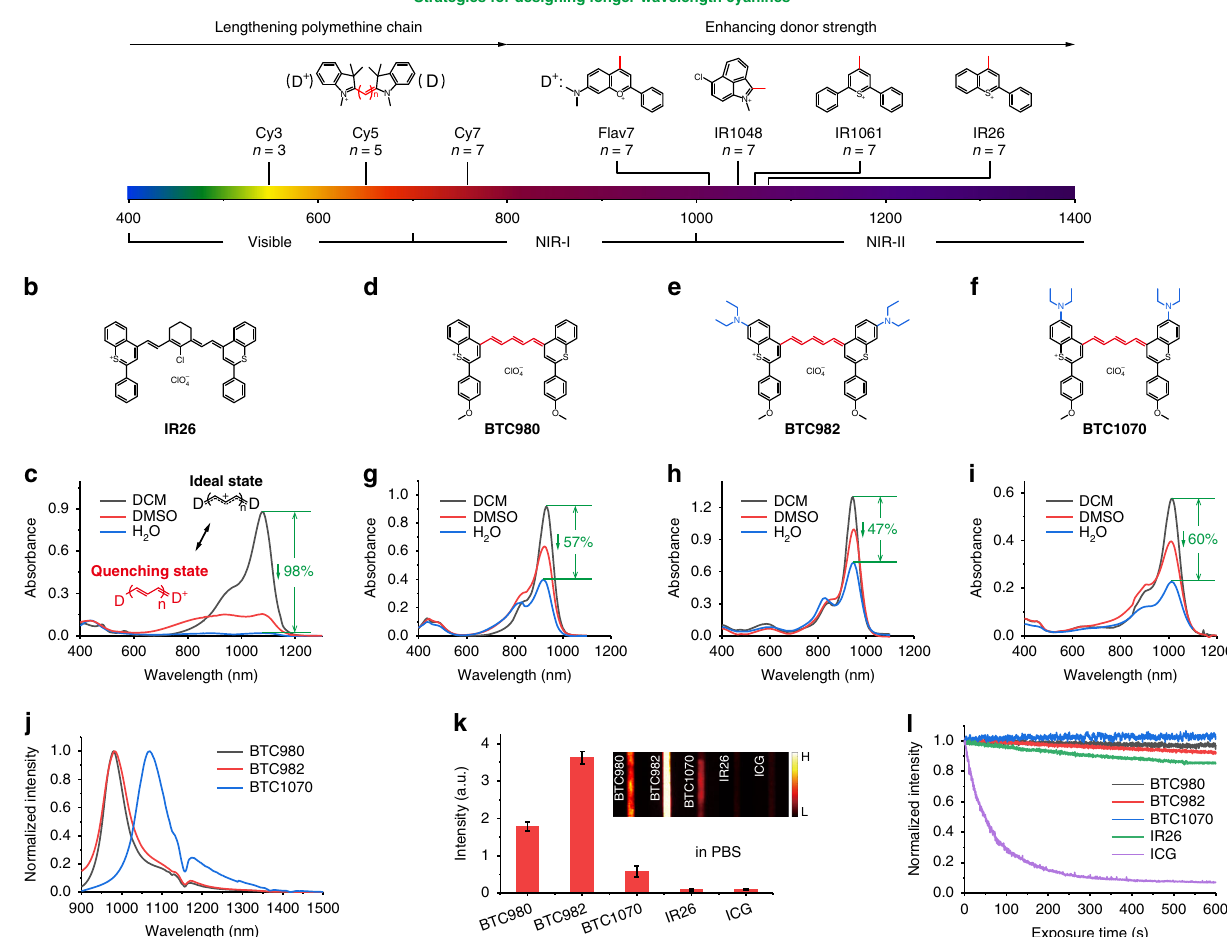
Fig. 1 Molecular design and spectra properties of NIR-II BTCs. a Schematic illustration shows the general strategies for tuning absorption wavelength of cyanines: lengthening polymethine chain (n denotes the number of methine unit) leads to bathochromic shift; however, enhancing donor (D) strength by heterocycle modi fi cation is a more-effective strategy to afford NIR-II absorbing/emitting cyanines. b , c Chemical structure b and absorption spectra c of IR26 in dichloromethane (DCM), dimethyl sulfoxide (DMSO) and H 2 O (phospholipid micelle formation). The ideal state, namely cyanine limit, presenting equalized charge and minimal bond length alternation in a symmetric cyanine structure, is characterized by intense and narrow absorption in nonpolar solvents such as DCM. Polar solvents such as DMSO and H 2 O break the symmetry, leading to weak and broad absorption, corresponding to a quenching state called as beyond the cyanine limit. d – f Rational design of pentamethine benzothiopyrylium cyanines ( d , BTC980, e , BTC982, and f BTC1070) by shortening polymethine chain (red) and introducing electron-donating diethylamino groups (blue). g – i Intense and sharp absorption spectra of BTC980 g , BTC982 h , and BTC1070 i (5 μ M ) in dichloromethane, dimethyl sulfoxide, and H 2 O (phospholipid micelle formation). j Normalized fl uorescence spectra of BTC980, BTC982, and BTC1070 in DCM. The ~ 1150 nm dips are caused by solvent absorption (Supplementary Figure 6). k NIR-II (1000 – 1700 nm)